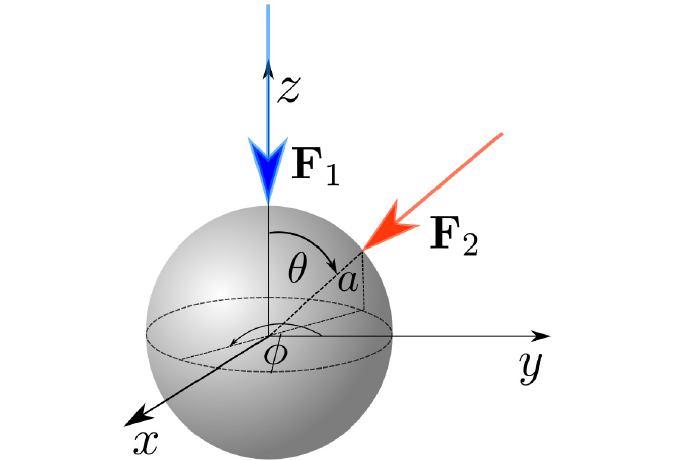
Fig 9. Spherical cell subject to two point forces F 1 and F 2 representing ‘phantom’propellingflagella.